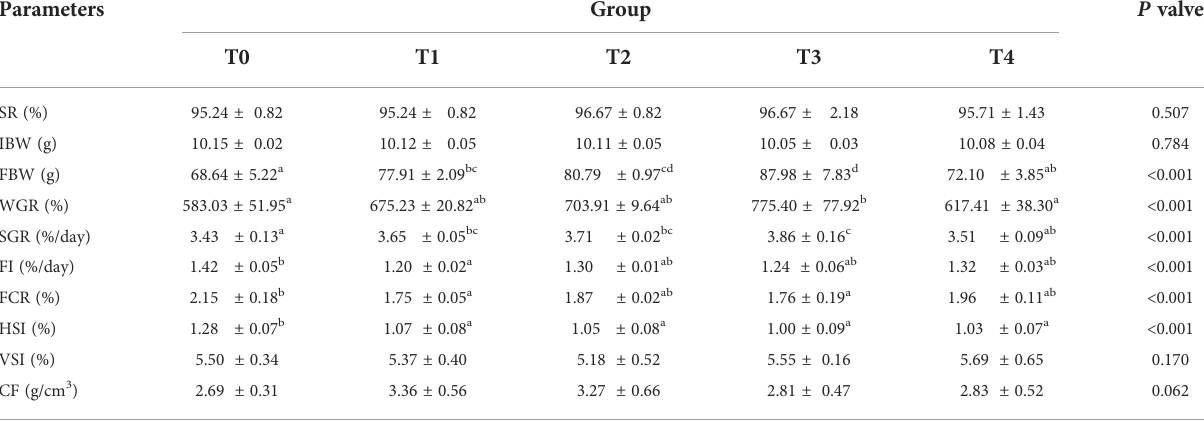
TABLE 4 Growth performance of T. ovatus fed diets with different dose taurine supplementation after 8 weeks. Parameters